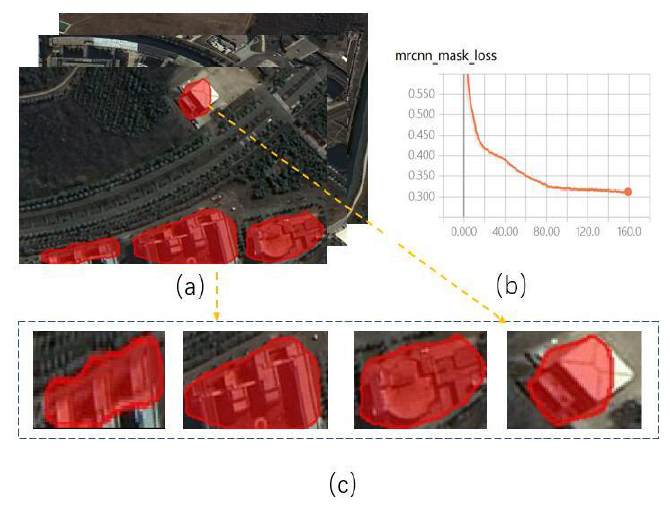
Figure 1. Building extraction based on Mask R-CNN. (a) The whole building extraction; (b) Loss function curve; (c) The single building extraction.